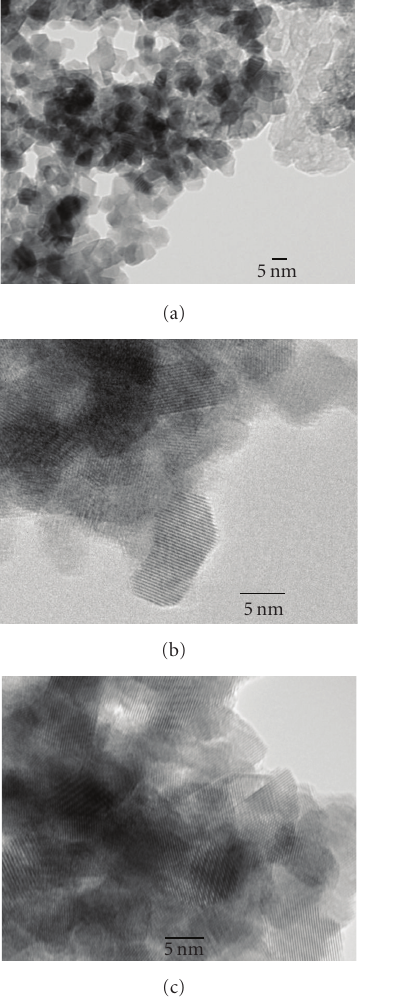
Figure 1: TEM images of 1wt% Ru (a), Pd (b), and Rh (c), supported GDC matrices. Scale bar: 5 nm.